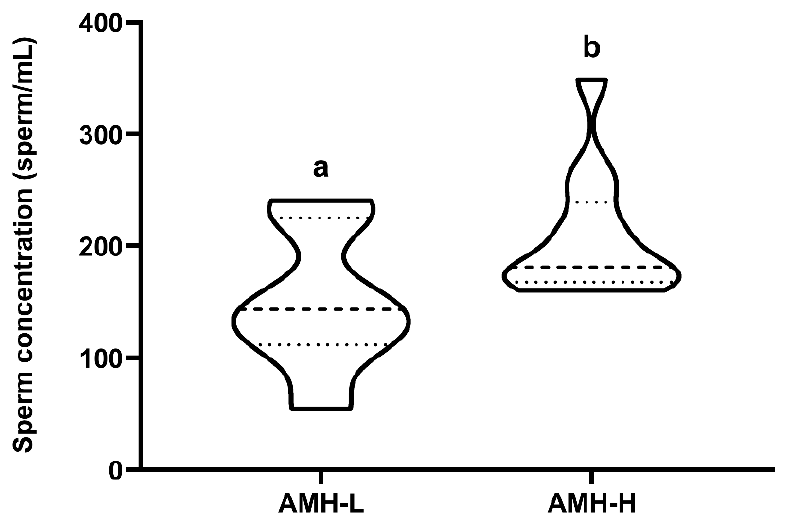
Figure 2. Relationship between concentration (ng/mL) of the anti ‐ Müllerian hormone in boar seminal plasma (SP ‐ AMH) and sperm concentration (sperm/mL). Violin plots represent levels and distribution of sperm concentration in boars hierarchically grouped ( p ˂ 0.001) as having low ‐ (AMH ‐ L; ranging from 479.92 to 701.84 ng/mL, n = 7) or high ‐ (AMH ‐ H; ranging from 770.53 to 1096.72 ng/mL, n = 19) SP ‐ AMH concentration. Dashed line represents the median and dotted lines the 25 and 75% quartiles. Different superscript letters ( a – b ) indicate significant differences between SP ‐ AMH groups ( p ˂ 0.05).